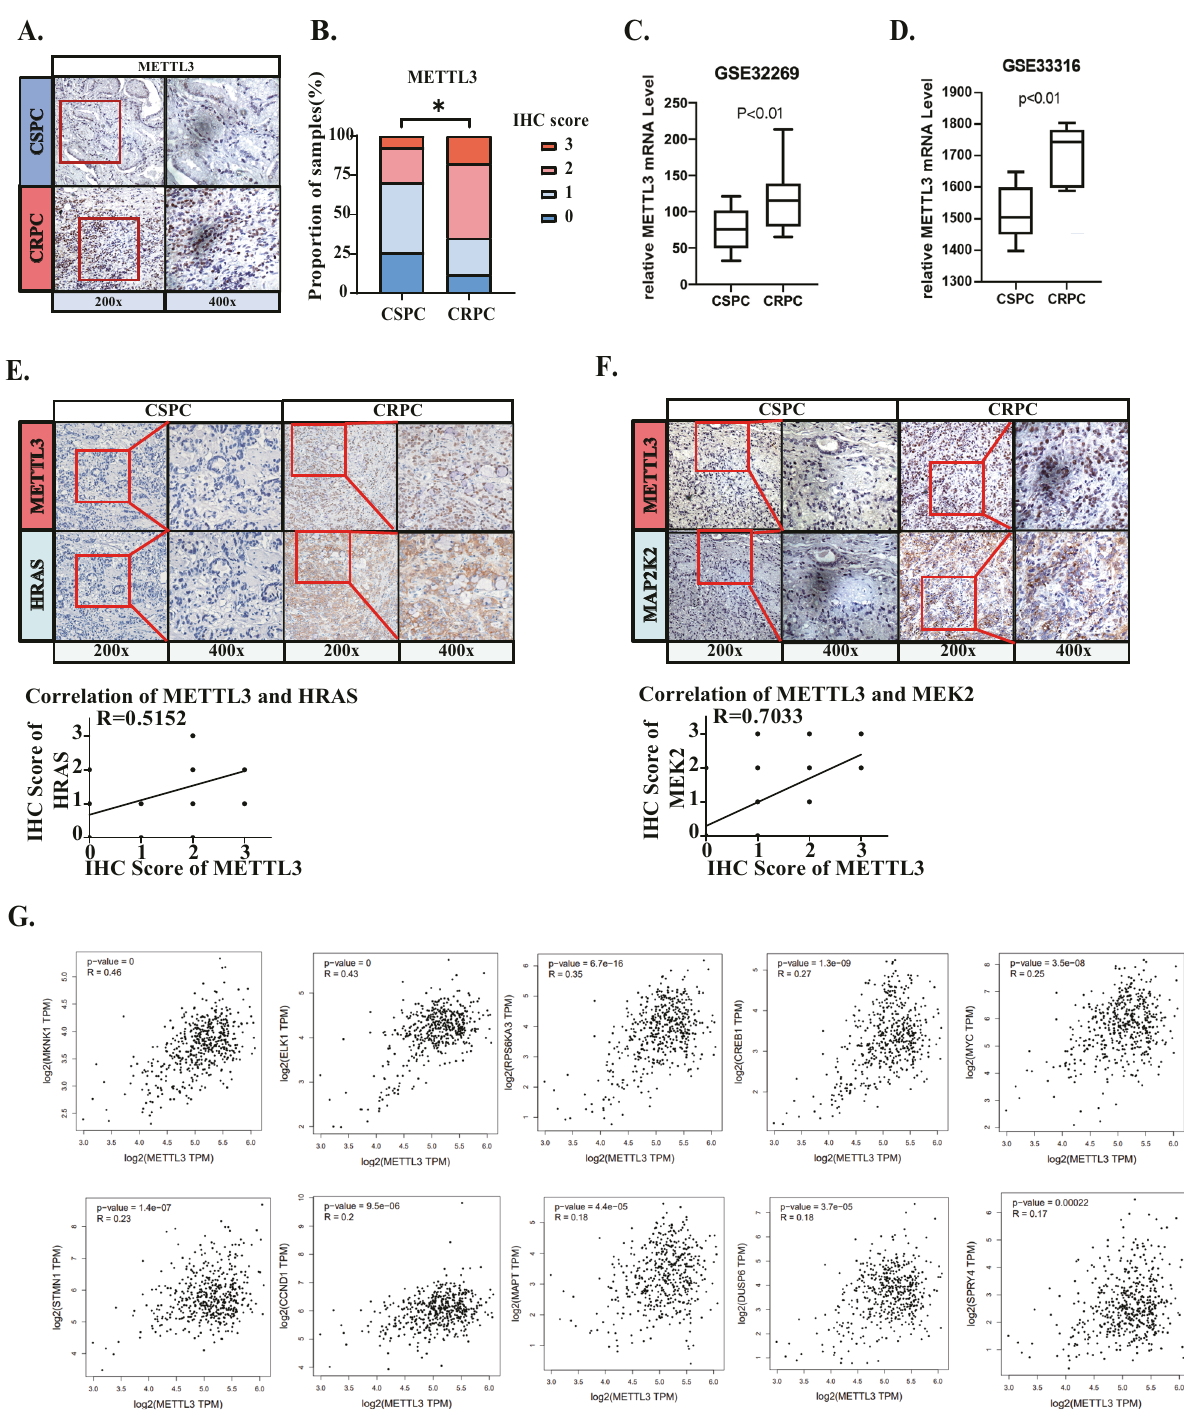
Fig. 2 Clinical analysis con fi rmed the positive correlated of METTL3 and HRAS/MEK2 in CRPC. A Images of IHC-stained tissue microarray showed that METTL3 protein levels in CSPC and CRPC. B Statistical results of the IHC-stained tissue microarray showing METTL3 protein levels in CRPC vs CSPC. C , D Visually analyze the transcriptome data from the GEO database to compare the mRNA levels of METTL3 (GSE32269, clinical CRPC/CSPC tissue data and GSE33316, PDX model before vs after castration). E , F The correlation of METTL3 and HRAS&MEK2 protein expression was veri fi ed by an IHC-stained tissue microarray. G TCGA database was analyzed and we found that METTL3 and ERK1/2 downstream genes are widely positively correlated at the RNA level.